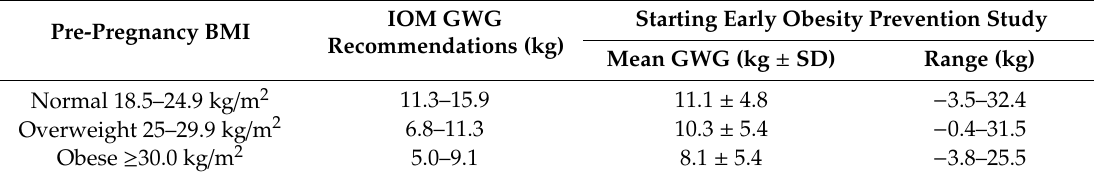
Table 1. Institute of Medicine gestational weight gain recommendations and mean and range of gestational weight gain among women participating in the Starting Early Obesity Prevention Study, stratified by pre-pregnancy body mass